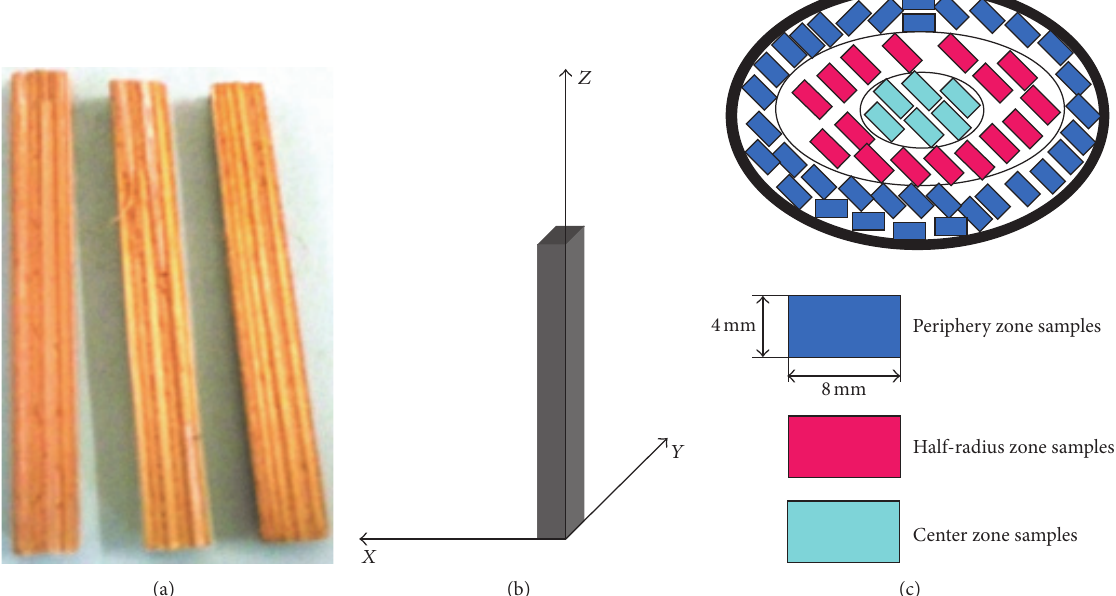
Figure 2: Illustration of the samples used for the test. (a) Picture of the sample, (b) axis orientation of the sample, and (c) extraction zone of the samples in the radial position.